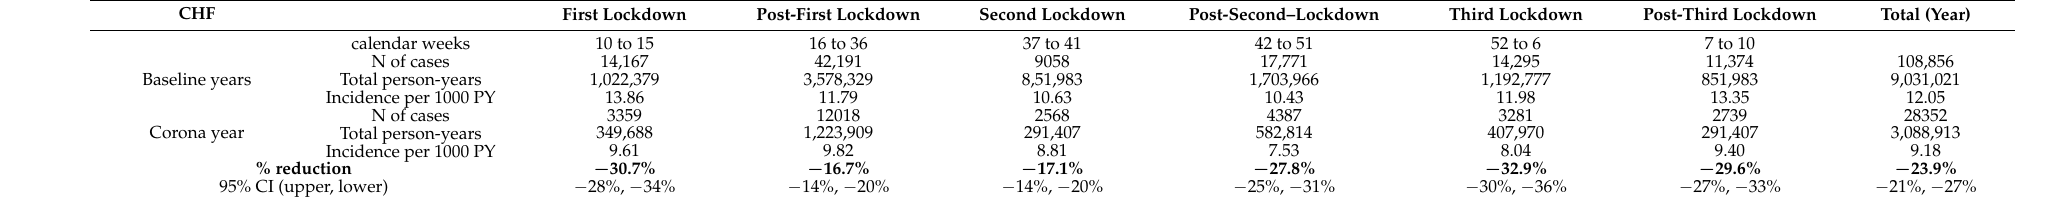
Table 4. CHF incidence by period during the Corona year and baseline